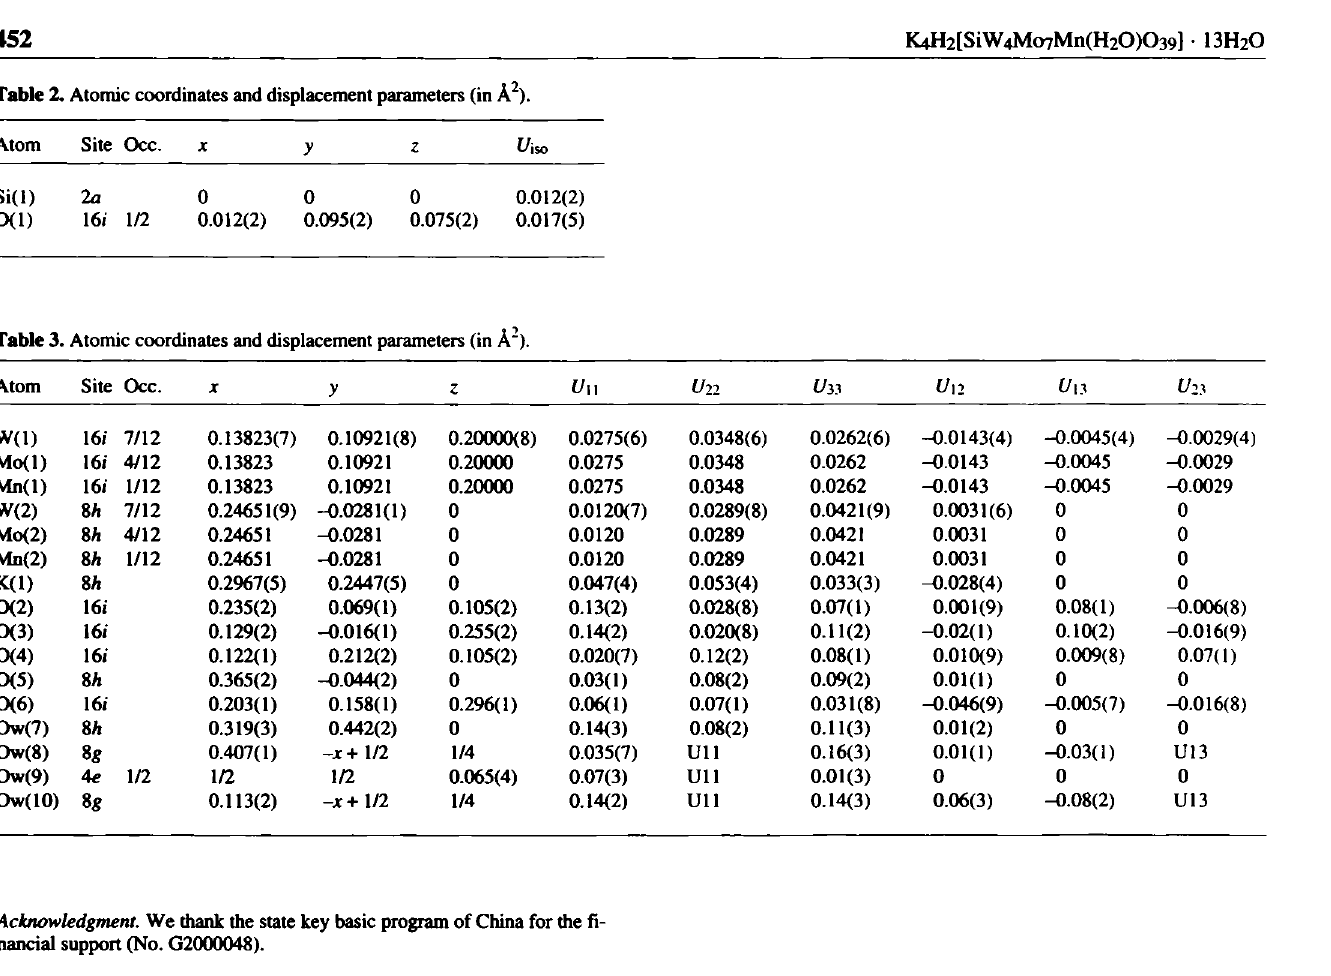
Table 2. Atomic coordinates and displacement parameters (in À 2 ).